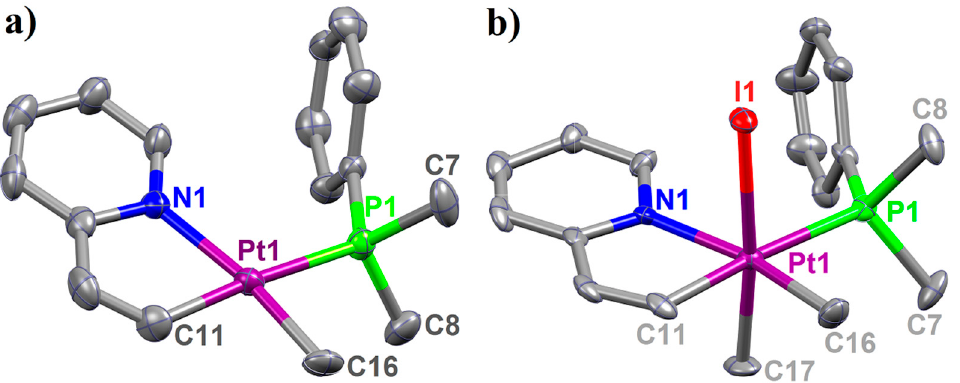
Figure 1. ( a ) ORTEP plot of the structure of 1c . Selected geometrical parameters (Å, °): Pt1-P1 2.306(2); Pt1-N1 2.141(6); Pt1-C11 2.013(8); Pt1-C16 2.077(7); C11-Pt1-N1 78.8(3); N1-Pt1-P1 104.34(18); P1-Pt1-C16 87.4(2); C16-Pt1-C11 89.6(4); C11-Pt1-P1 175.5(3); N1-Pt1-C16 168.2(3). ( b ) ORTEP plot of the structure of 2c . Selected geometrical parameters (Å, °): Pt1-P1 2.395(6); Pt1-N1 2.142(19); Pt1-C11 1.98(2); Pt1-C16 2.01(3); Pt1-C17 2.19(2); Pt1-I1 2.7669(18); C11-Pt1-N1 79.1(9); N1-Pt1-P1 105.4(6); P1-Pt1-C16 84.2(8); C16-Pt1-C11 91.3(11); C11-Pt1-P1 175.4(7); N1-Pt1-C16 170.0(10); C17-Pt1-I1 175.4(7). Ellipsoids are drawn at the 50% probability level, and hydrogen atoms are omitted for clarity.